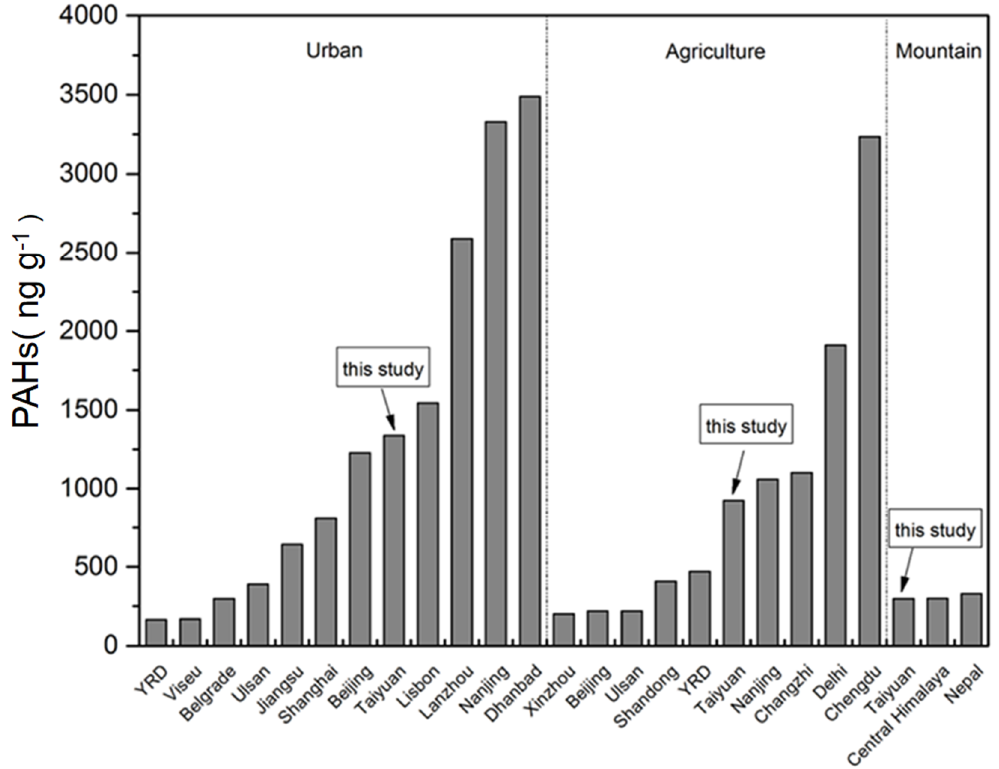
Figure 2. PAH (Polycyclic aromatic hydrocarbon) concentrations (ng g −1 ) in urban, agricultural, and mountain soil from Taiyuan and other areas.